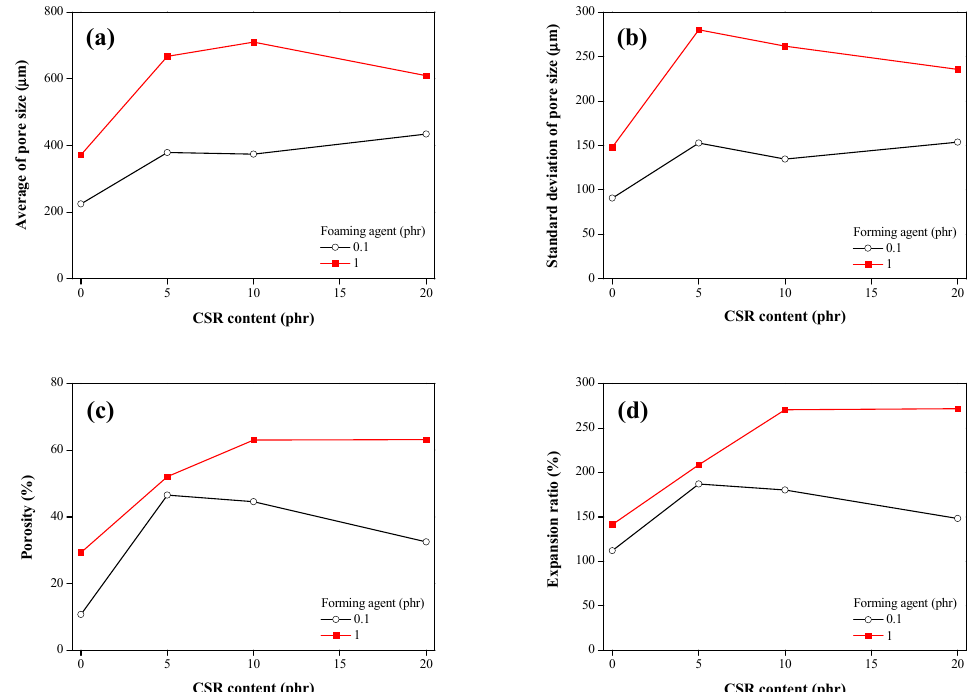
Figure 6. ( a ) Average and ( b ) standard deviation of pore size, ( c ) porosity, and ( d ) expansion ratio of CSR/epoxy composite foam adhesives.